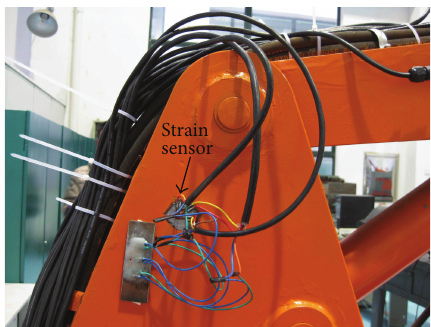
Figure 10: Strain sensor pasted on the supports during the experi- ment.